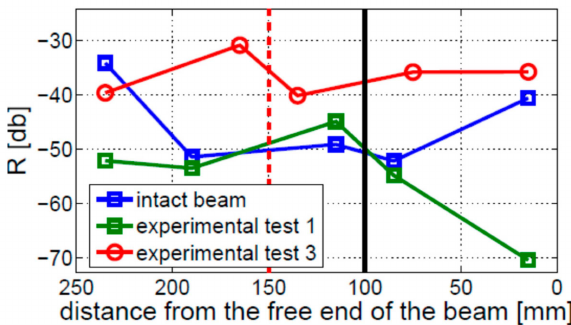
Figure 23. Level of nonlinearity estimated for the fixed–free beam, for two different crack locations indicated by the vertical solid black (Experimental Test 1) and dashed red (Experimental Test 3) lines.